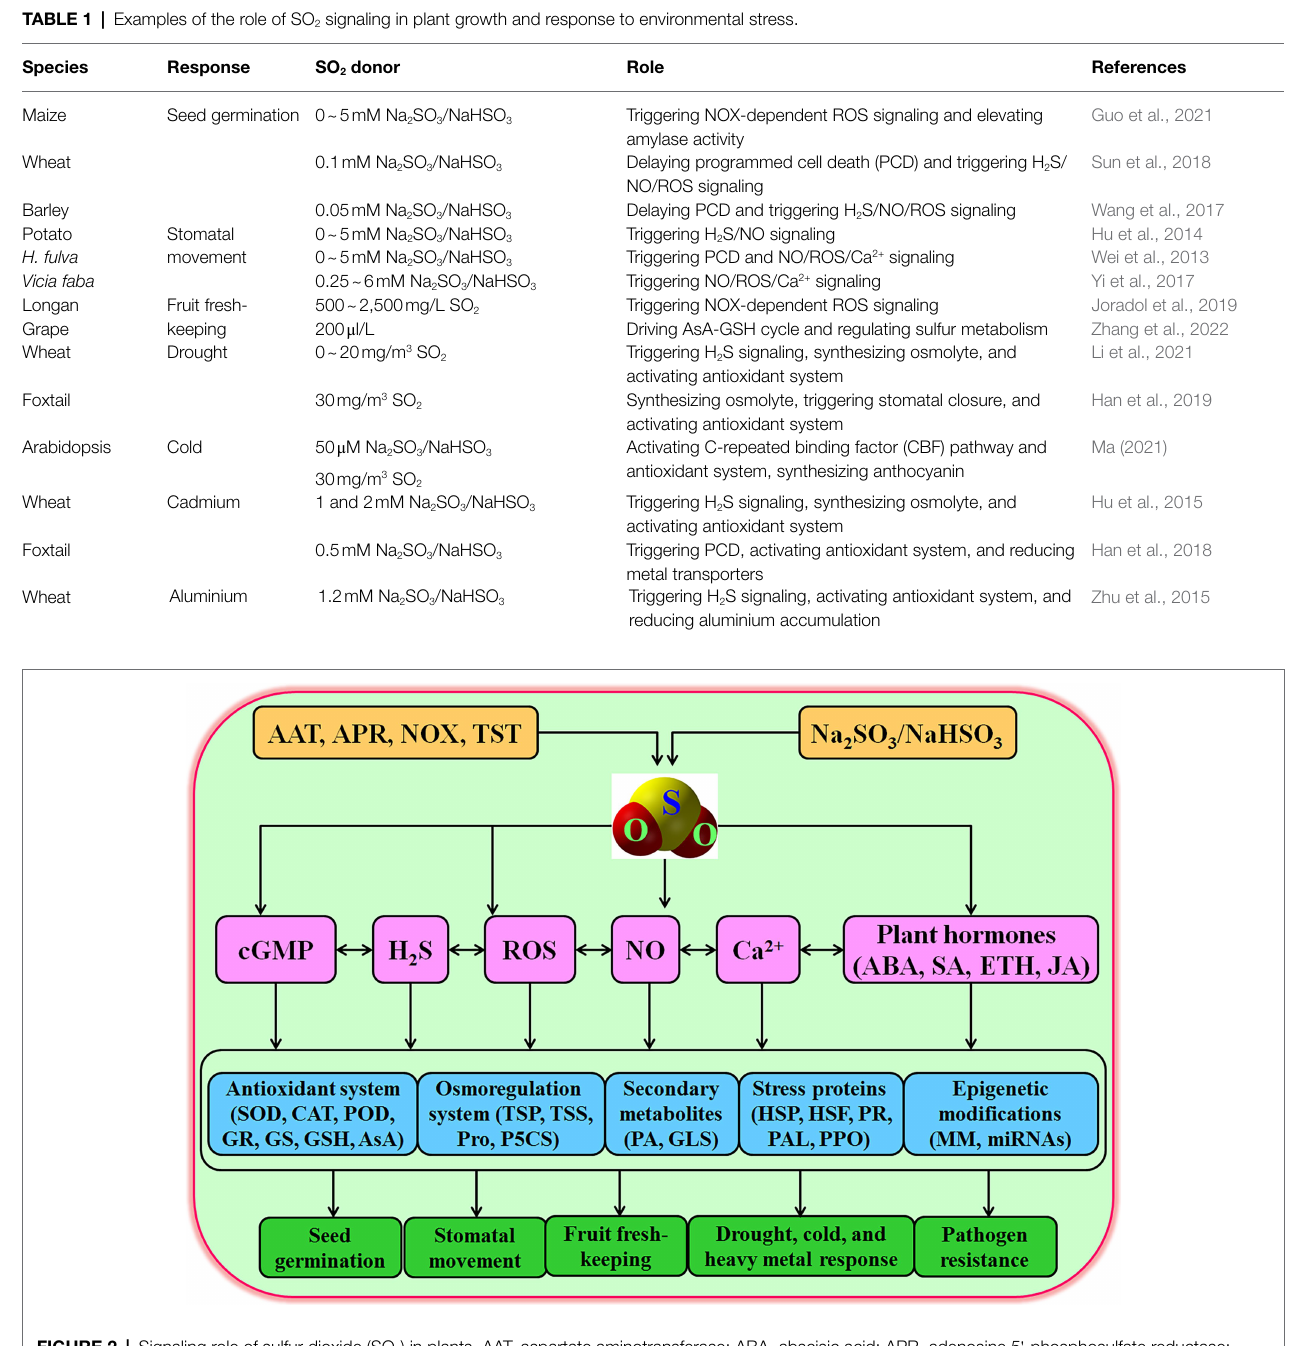
FIGURE 2 | Signaling role of sulfur dioxide (SO 2 ) in plants. AAT, aspartate aminotransferase; ABA, abscisic acid; APR, adenosine 5 ' -phosphosulfate reductase; AsA, ascorbic acid; CAT, catalase; cGMP, cyclic guanosine monophosphate; ETH, ethylene; GR, glutathione reductase; GS, glutathione synthetase; GSH, glutathione; GSL, glucosinolate; H 2 S, hydrogen sulfide; HSF, heat shock factor; HSP, heat shock proteins; JA, jasmonic acid; MM, methylation modification; NO, nitric oxide; NOX, NADPH oxidase; PA, phytoalexins; PAL, phenylalanine ammonia-lyase; P5CS, Δ 1 -pyrroline-5-carboxylate synthetase; POD, peroxidase; PPO, polyphenol oxidase; PR, pathogenesis-related proteins; Pro, proline; ROS, reactive oxygen species; SA, salicylic acid; SOD, superoxide dismutase; TSP, total soluble proteins; TSS, total soluble sugars; TST, thiosulfate sulfurtransferase. while had lower activities of lipoxygenase (LOX) and polyphenol PCD in both SO 2 – and H 2 S-pretreated aleurone cells (Sun oxidase (PPO; Sun et al., 2018). Also, SO 2 -pretreated aleurone et al., 2018). These results indicate that SO 2 can trigger H 2 S/ layers induced the production of endogenous H 2 S and NO, NO signaling to delay PCD in wheat aleurone layers pretreated whereas the supplement of cPTIO (NO scavenger) accelerated with gibberellin via activating antioxidant enzyme system.